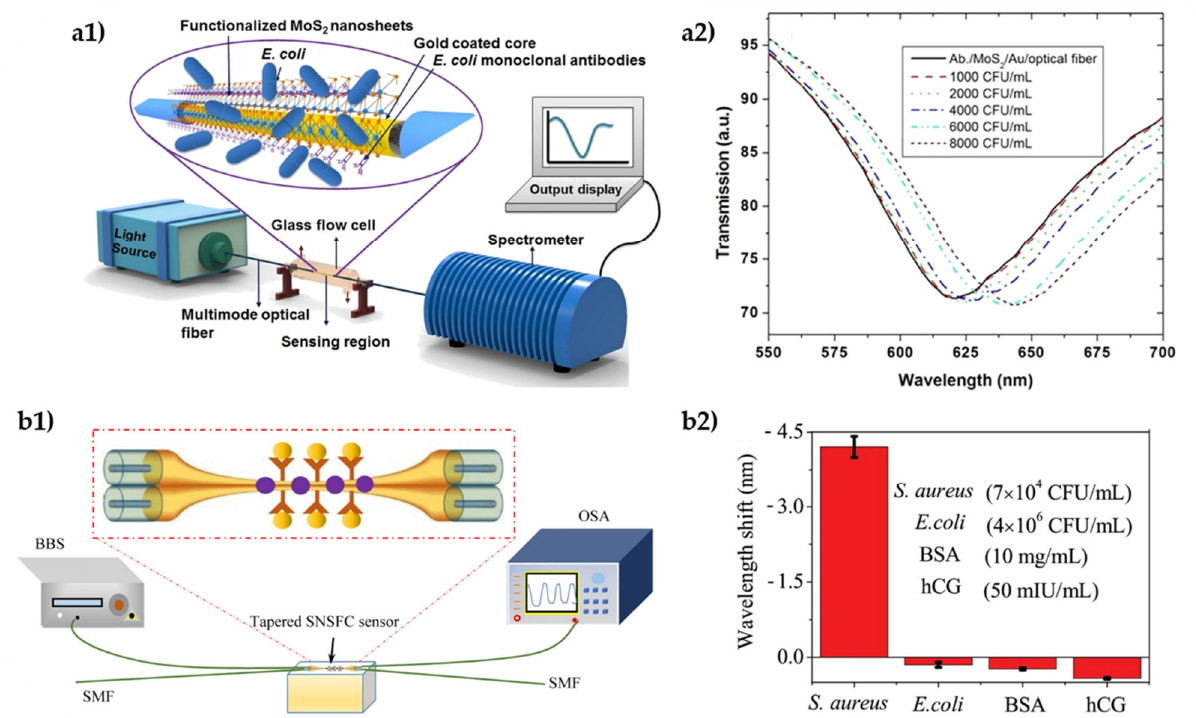
Figure 11. ( a1 ) Schematic representation of the setup for the development of MoS 2 nanosheets-modified, Au-coated, uncladded and etched silica optical fiber for E. coli detection, and the anti- E.coli antibodies were bonded by hydrophobic interaction to MOS 2 . ( a2 ) Transmission spectra as response to E. coli concentration. Reprinted with permission from ref. [114]. Copyright 2019 Elsevier. ( b1 ) Schematic representation of the setup for the development of tapered single-mode − no-core − single-mode fiber coupler (SNSFC) structure for S. aureus detection; the fiber was silanized and the anti- S. aureus antibodies were covalently linked using EDC/NHS chemistry. ( b2 ) Wavelength shift of the transmission spectra as response to the analyte and the controls. Reprinted with permission from ref. [124]. Copyright 2020 Elsevier, Amsterdam, The Netherlands.